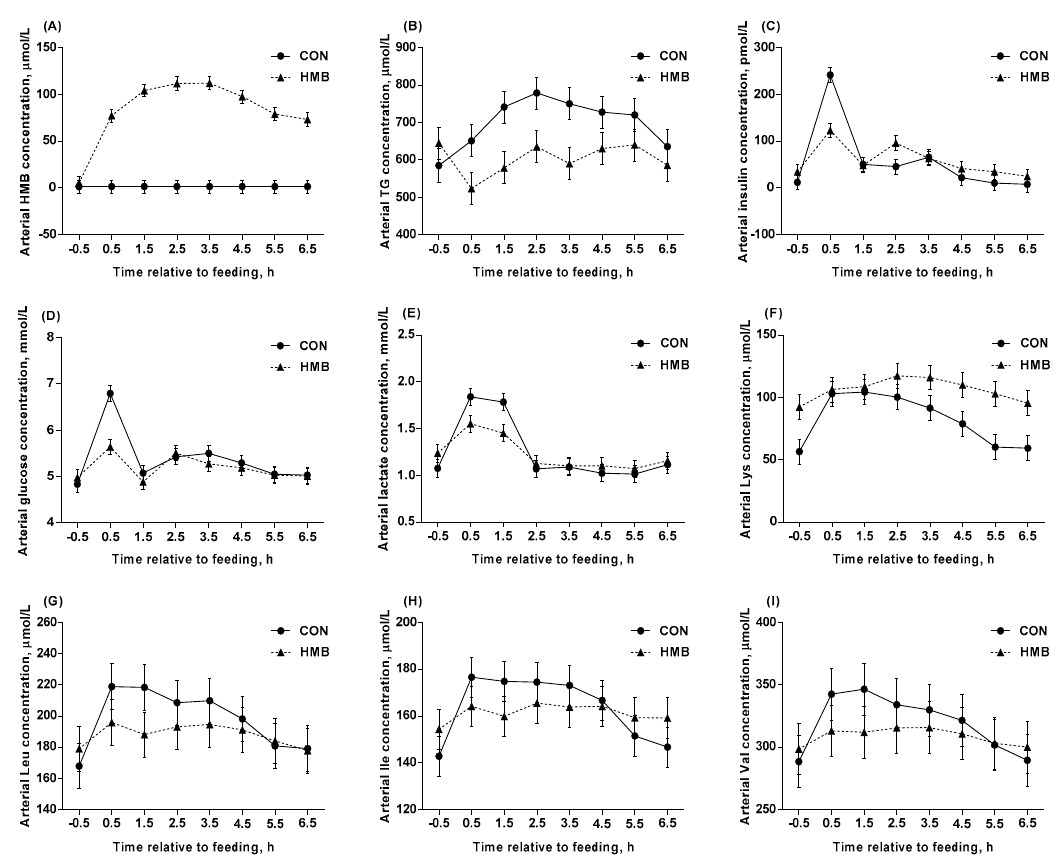
Figure 2. Arterial concentrations of HMB ( A ), TG ( B ), insulin ( C ), glucose ( D ), lactate ( E ), Lys ( F ), Leu ( G ), Ile ( H ), and Val ( I ) in control (CON) and HMB-supplemented (HMB) sows during late gestation. Data are expressed as the mean ± SEM. Sows were regarded as the experimental units, n = 4 for each group. Interaction of treatment and sampling time after feeding were observed for arterial concentration of HMB ( p < 0.001), TG ( p = 0.06), insulin ( p < 0.001), glucose ( p < 0.001), lactate ( p = 0.002), Lys ( p = 0.003), Leu ( p = 0.02), Ile ( p = 0.006), and Val ( p = 0.006), respectively. CON = control; HMB = β -hydroxy- β -methyl butyrate; TG = triglycerides.